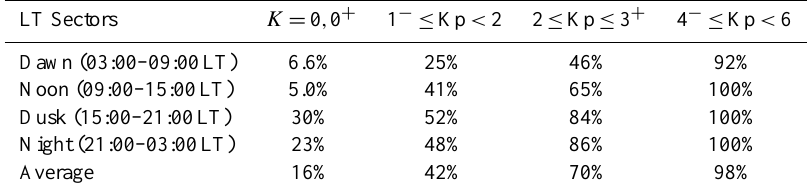
Table 2. The penetration ratio ρ of IBIPS inside geosynchronous orbit in four local time sectors for different Kp bins. LT Sectors K = 0 , 0 + 1 − ≤ Kp < 2 2 ≤ Kp ≤ 3 + 4 − ≤ Kp < 6 Dawn (03:00–09:00LT) 6.6% 25% 5.0% Dusk